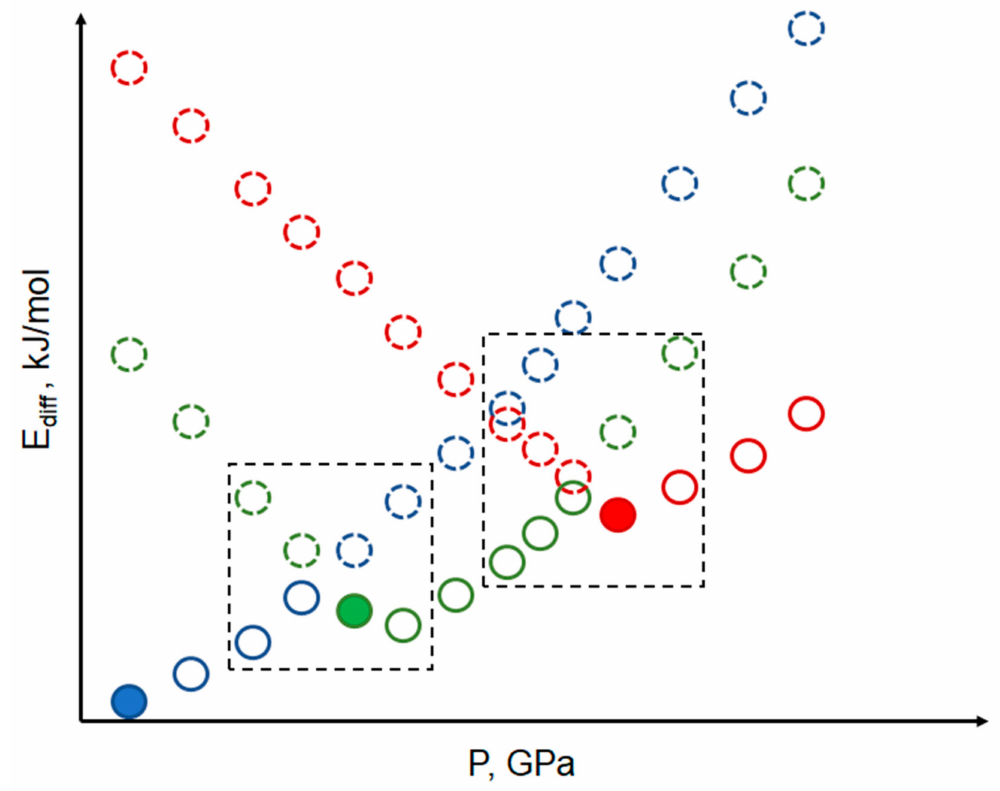
Figure 1. Schematic representation of calculated energy parameters ( ∆ U crystal , ∆ H, etc.) for di ff erent phases in the whole pressure range, even at pressures where a specific phase is not found experimentally. Solid dots filled with color, starting experimental structure for DFT optimization; solid empty dots, DFT optimized structure at fixed pressure as observed experimentally; dashed dots, DFT optimized structure at fixed pressure out of experimental pressure range. Blue, phase I; green, phase II; red, phase III. Dashed squares show pressure-energy conditions close to high-pressure phase